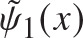
Same as Figure 2, but now for an axisymmetric power-law disc with p = −0.5. Note that for this disc model softened ψ˜1x does not cross zero and converges to a positive value as x → 0, in agreement with the results in Figure 1A.